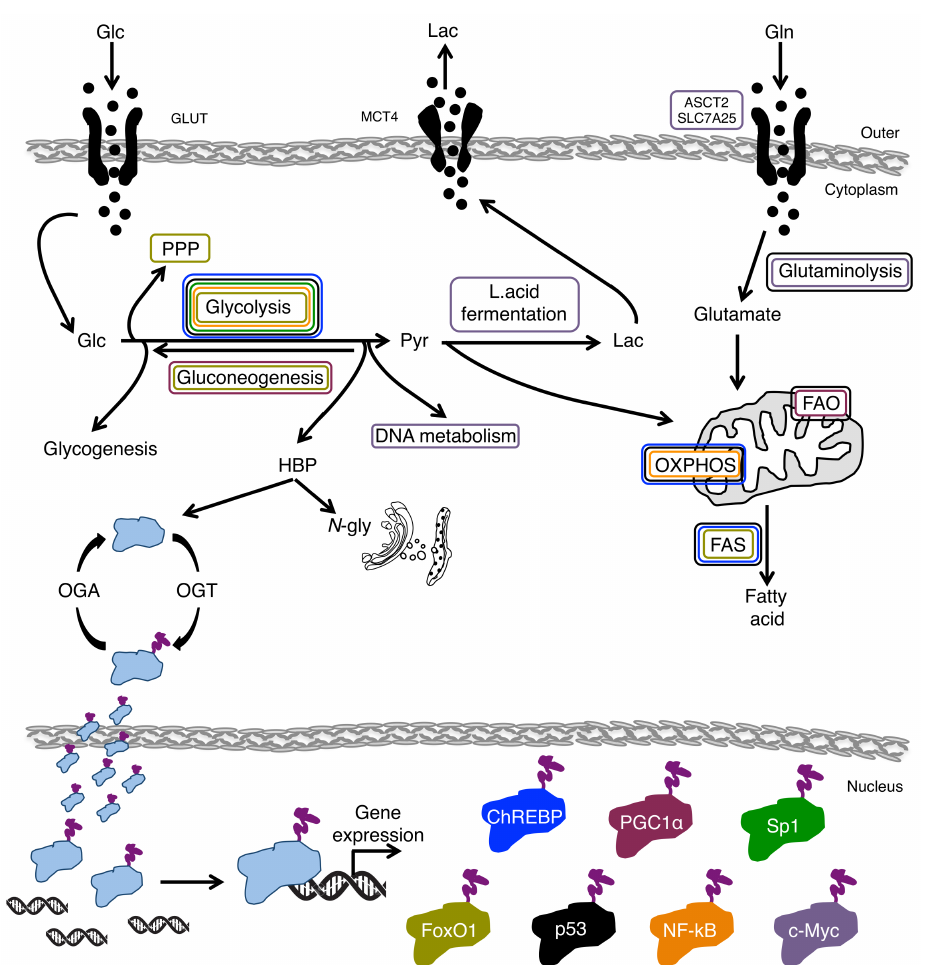
Figure 4. Schematic representation of the main metabolic pathways influenced (positively and/or negatively) by transcriptional factor O- Glc N Acylation. The figure depicts, from a schematic point of view, the transcriptional factors whose stability, transcriptional activation, DNA binding ability and protein–protein interaction is regulated by direct O- Glc N Acylation and the metabolic pathways influenced by their O- Glc N Acylation. The colored square around the indicated metabolic pathways is related to the specific transcriptional factor that upon O- Glc N Acylation is able to control the